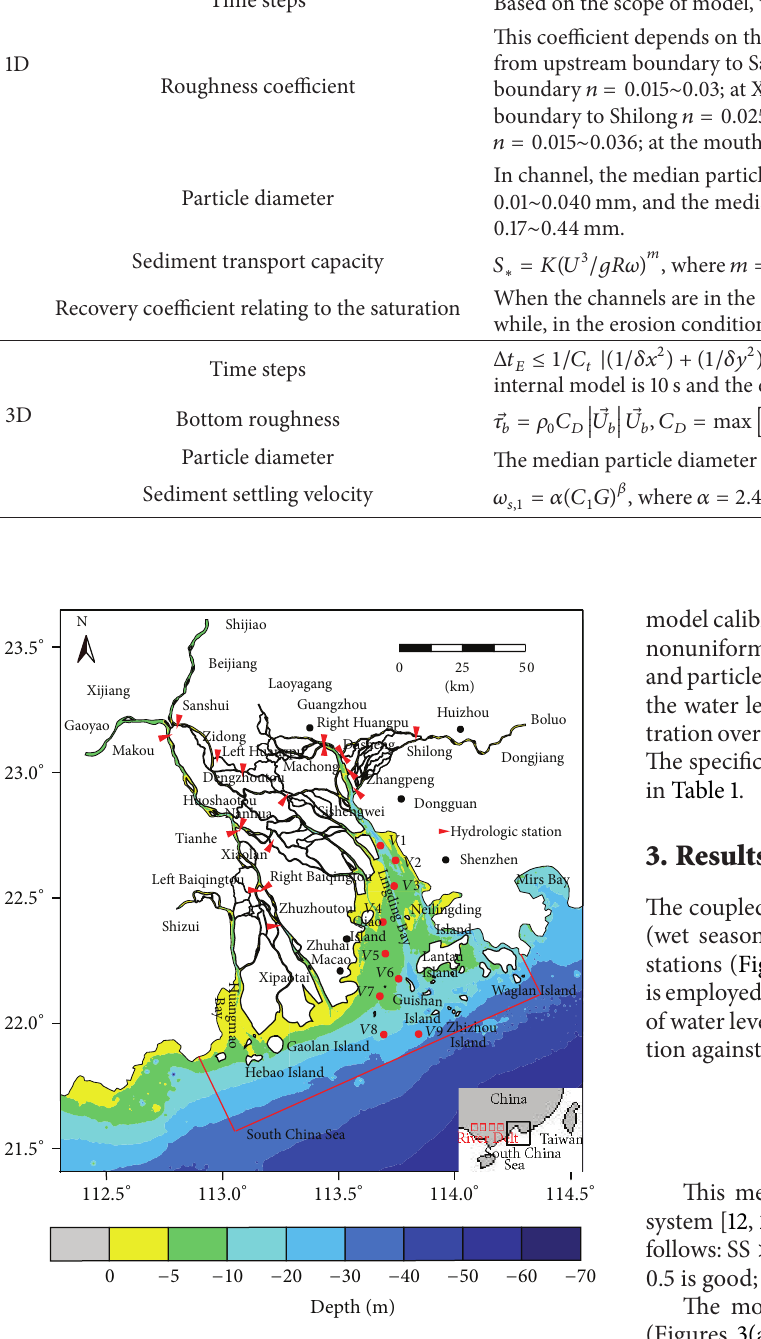
Figure 2: Map of the study area including (1) the location of the Pearl River network with the names of the three major rivers and (2) the major topographic features of the Pearl River Estuary with isobaths in colors. The upstream boundaries of the 1D model are shown on the map, which starts with Shizui, Gaoyao, Shijiao, Laoyagang, and Boluo. The downstream boundaries of the 3D coastal model extend to the − 30m isobaths. Black circles represent majorcities. Redtrianglesandredcirclesrepresentthemainstations in the Pearl River network and the Pearl River Estuary,